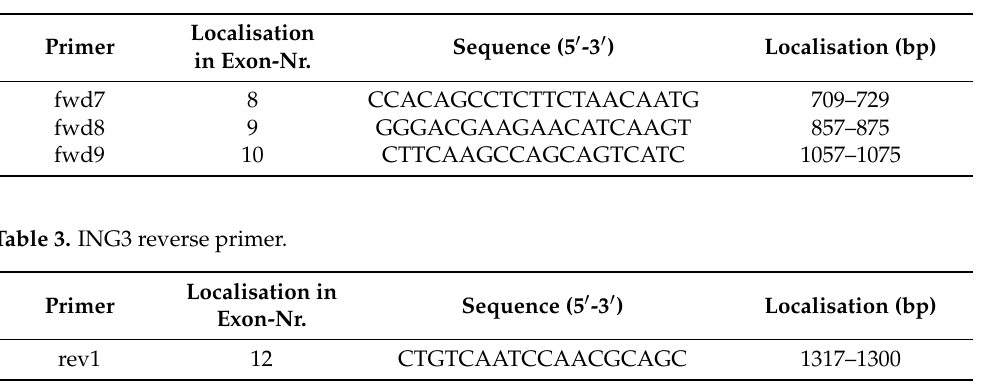
Table 2. ING3 forward primers.